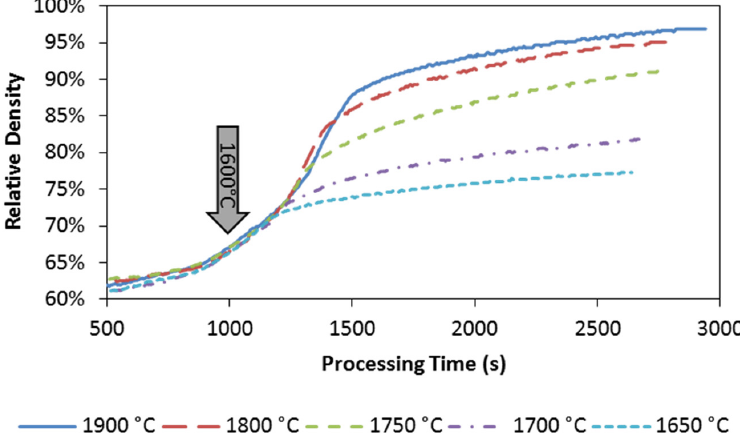
Figure 3. Relative density evolution with respect to processing time: single-die SPS at maximum processing temperature of 1900 °C, 1800 °C, 1750 °C, 1700 °C, and 1650 °C, respectively. Arrow is associated with the temperature of 1600 °C.